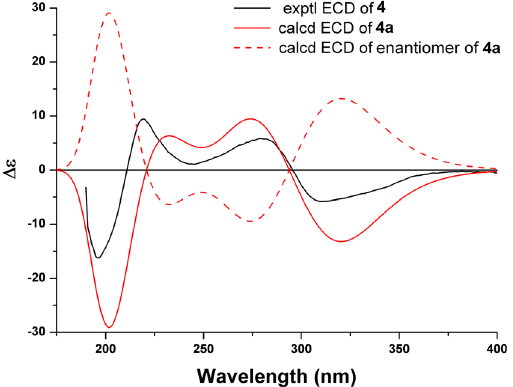
Figure 9. Experimental ECD spectrum of 4 and TDDFT calculated ECD spectra for 4a (1 R , 4 R , 5 S , 9 S ) and enantiomer of 4a .